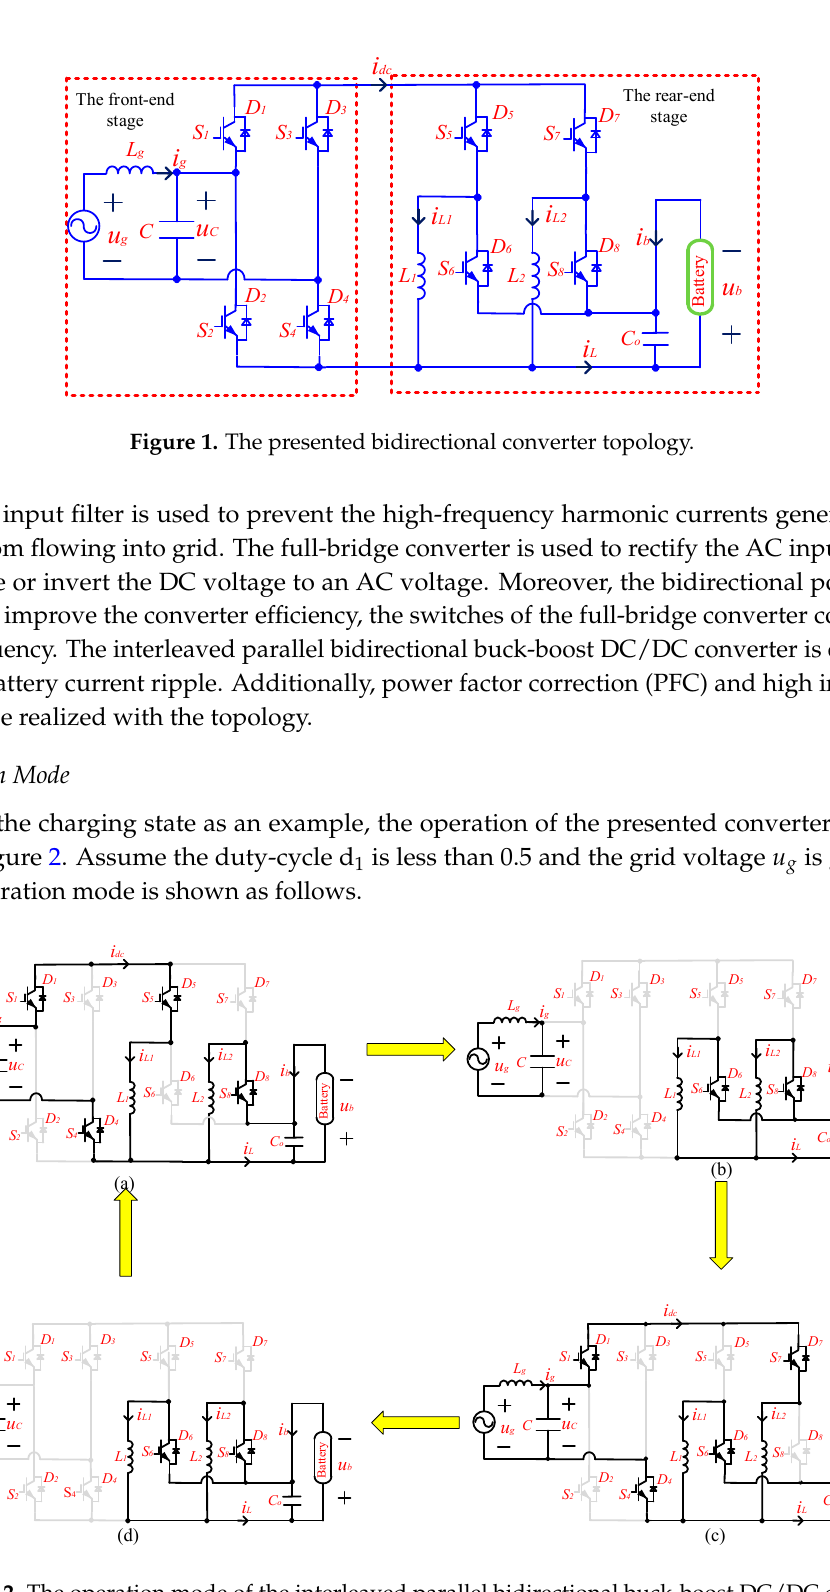
Figure 2. The operation mode of the interleaved parallel bidirectional buck-boost DC/DC circuit.